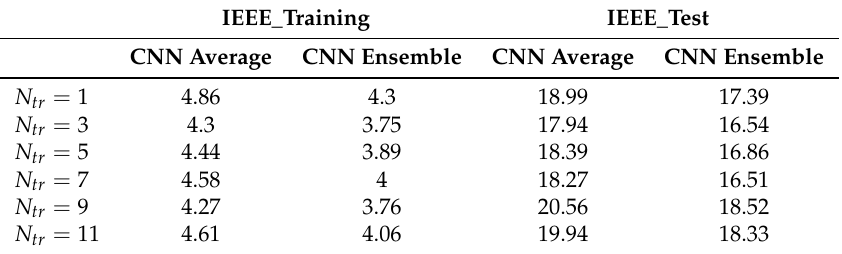
Table 6. Evaluation of the number of tracking segments ( N tr ). Average and ensemble prediction results are given, based on the 7